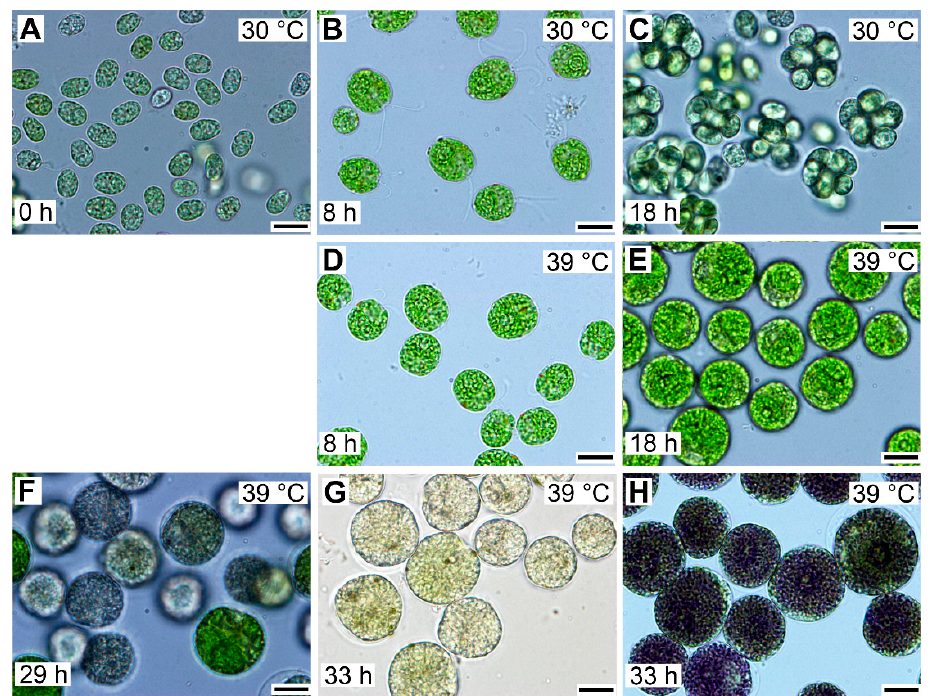
Figure 3. Photomicrographs of cells in synchronized cultures of Chlamydomonas reinhardtii grown in incident light 500 µmol m − 2 s -1 at 30 °C ( A – C ) or 39 °C ( D – H ). The cultivation temperature and the cell age in hours are indicated in the pictures. The control cells, grown at 30 °C, divided at 18 h and